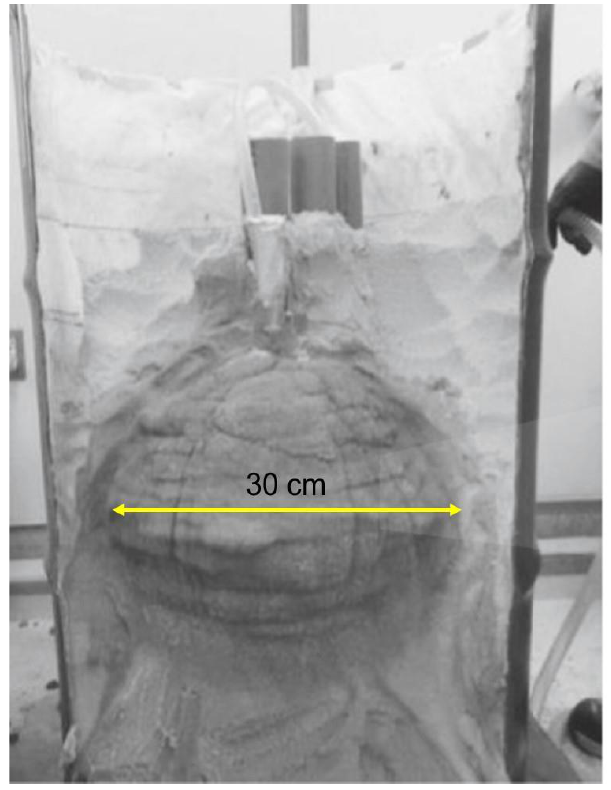
Figure 7. Improved sample after treatment by EICP grouting solution in a drum-can experiment [30].